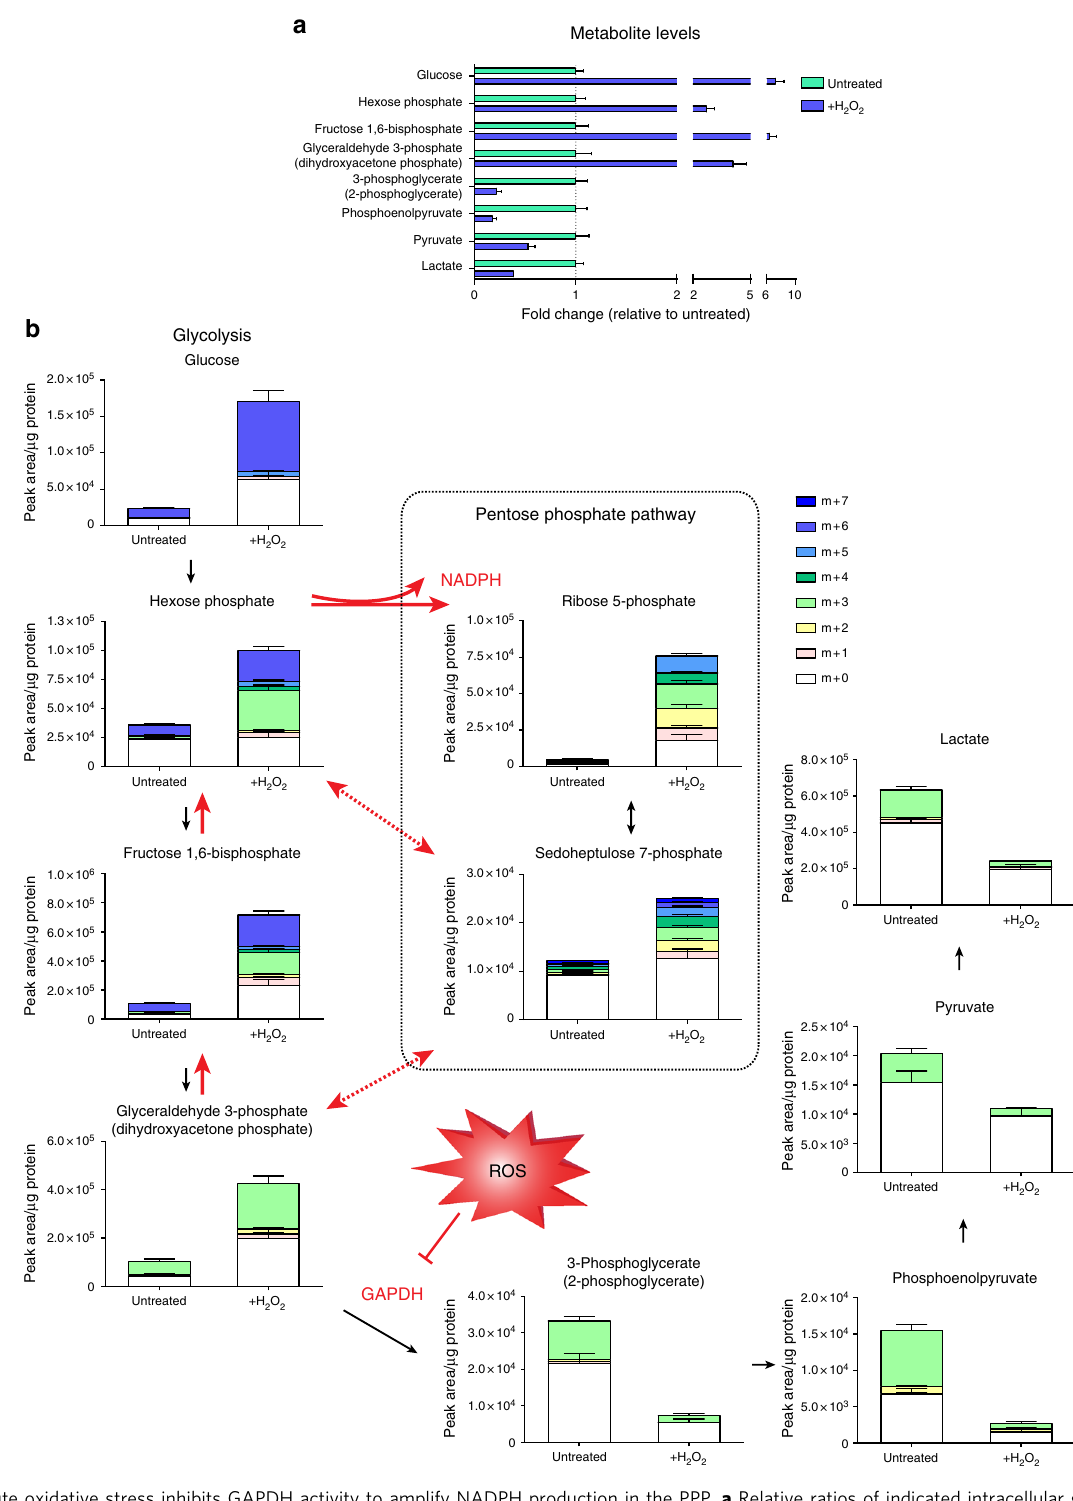
Fig. 5 Acute oxidative stress inhibits GAPDH activity to amplify NADPH production in the PPP. a Relative ratios of indicated intracellular glycolytic metabolites after treatment with 500 µ M hydrogen peroxide for 15 min. b Isotopologue distribution of intracellular metabolites in glycolysis and the pentose phosphate pathway after incubation with 13 C 6 -glucose and 500 µ M hydrogen peroxide for 15 min. a , b All graphs show mean (S.D.) of three independent experiments with triplicate